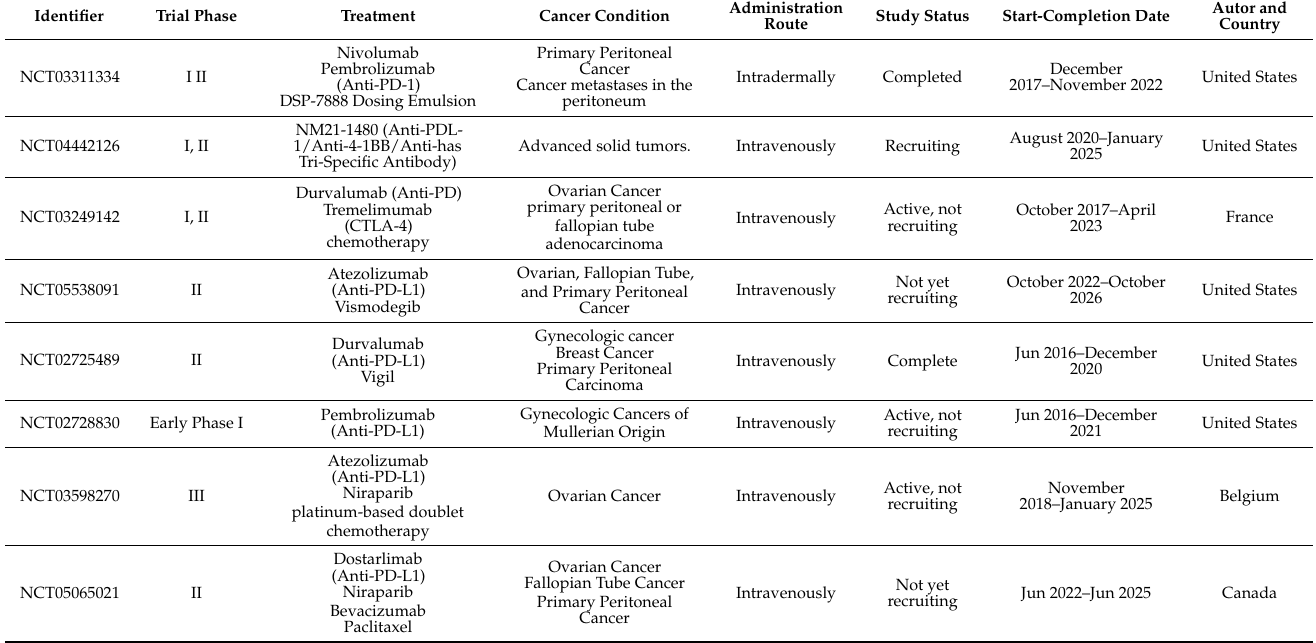
Table 1. Ongoing clinical trials with immune checkpoint inhibitors alone therapy in PCa (source: clinicaltrials.gov (accessed on 25 February